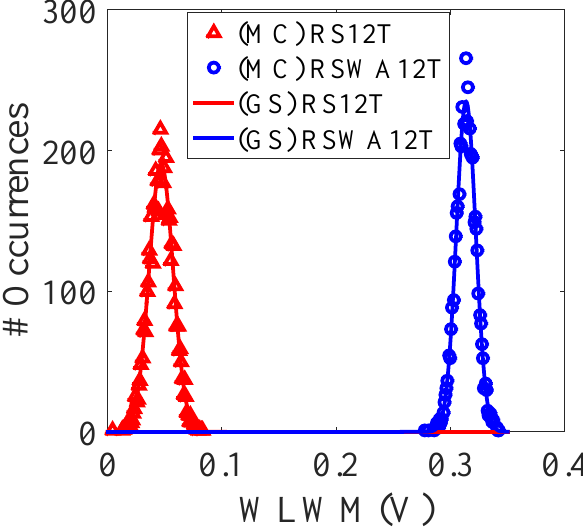
Figure 27. Process Variation effect analysis on proposed SRAM